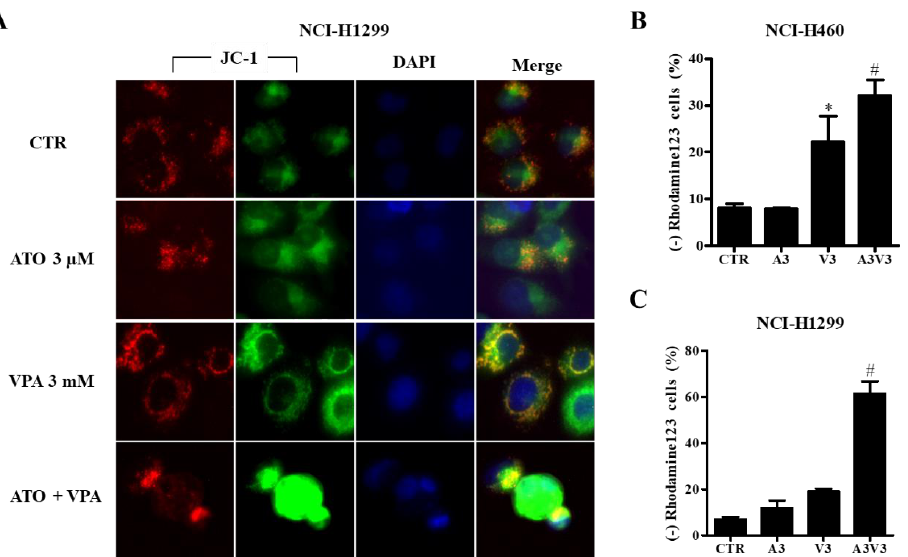
Figure 4. Effect of ATO and VPA alone and in combination on mitochondrial membrane potential (MMP) (∆Ψm). Exponentially growing cells were treated with 3 µM ATO and/or 3 mM VPA for 72 h. A : Representative images of JC-1 (red and green) and DAPI (blue) in NCI-H1299 cells (100×). Red fluorescent images indicate higher MMP (∆Ψm) levels. Green fluorescent images show lower MMP (∆Ψm) levels. B and C : Graphs show the proportions of Rhodamine 123-negative (MMP (∆Ψm) loss) cells in NCI-H460 cells ( B ) and NCI-H1299 cells ( C ) as measured by BD Accuri C6 flow cytometry. * p < 0.05 as compared with the control group. # p < 0.05 as compared with cells treated with ATO or VPA. ( n = 3).